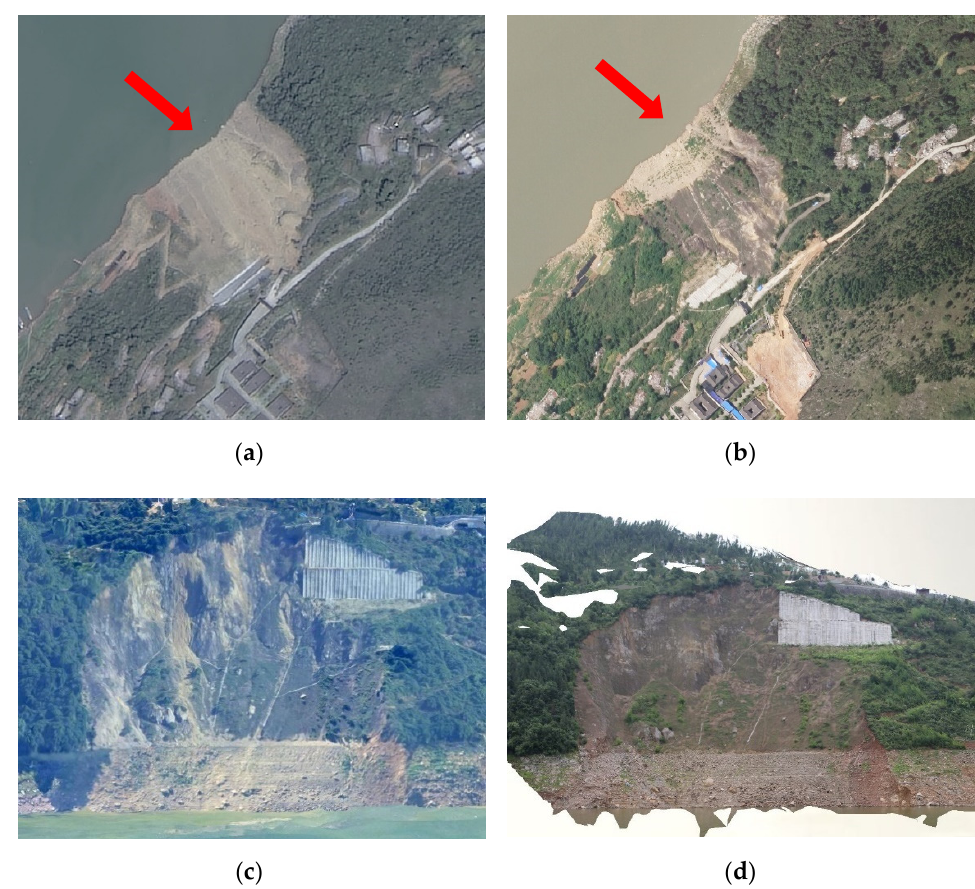
Figure 13. Large landslide depicted by different remote sensing data. ( a ) GF-2 satellite image; ( b ) aerial orthophotograph; ( c ) oblique photogrammetric 3D model; ( d ) shipborne photogrammetric 3D model. The area of the landslide is approximately 17,300 m 2 , the length is 174 m, and the width is 138 m. The landslide indicated by the red arrows occurred on 24 June 2015, and treatment work had been conducted when the remote sensing data were acquired. Because the area of the landslide was very large, it is visually recognizable in all remote sensing data sets.